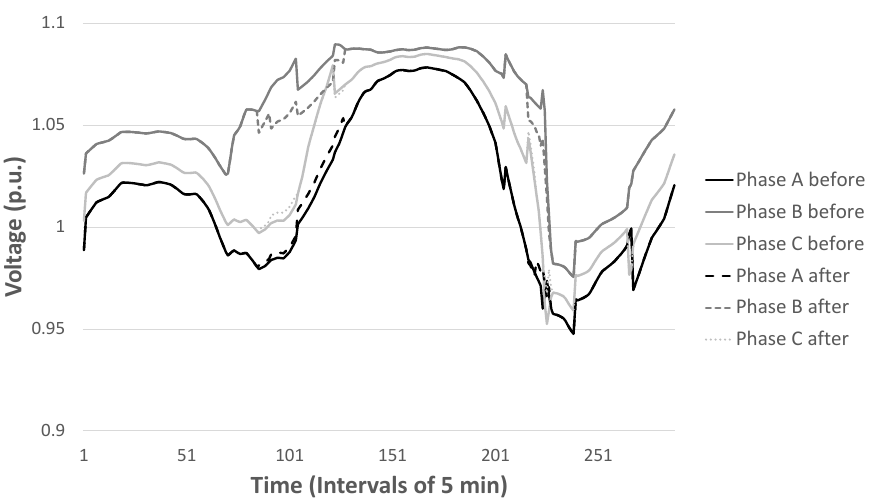
Figure 13. Three-phase voltage at bus LV4 before and after the proposed volt/var control method is